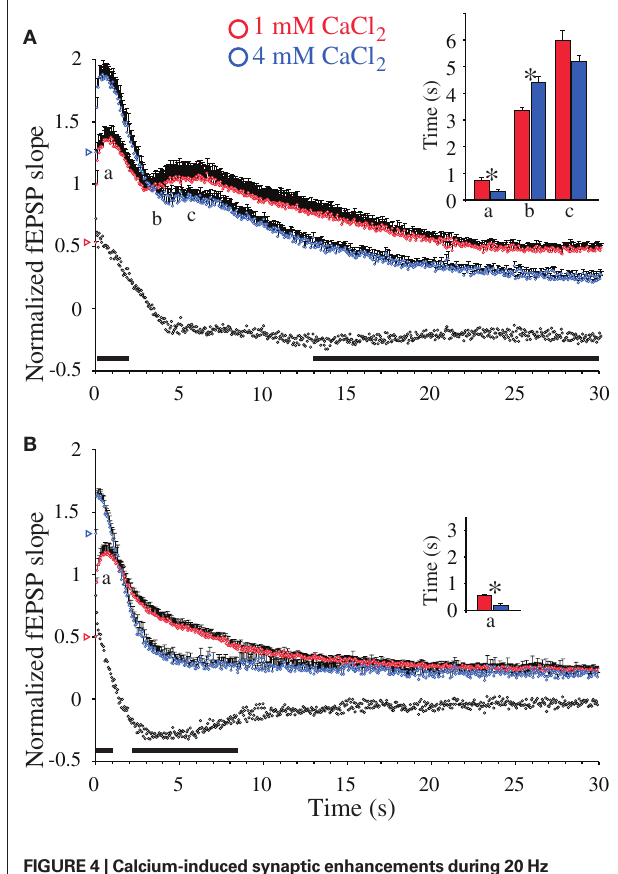
Figure 4 | Calcium-induced synaptic enhancements during 20 Hz stimulation in hippocampal excitatory CA3-to-CA1 synapses. (A) Normalized fEPSP slope measurements from CA3-to-CA1 synapses during 20 Hz stimulation in slices ( n = 12) from WT mice treated with 4 mM CaCl (blue 2 symbols) and in experiments with 1 mM CaCl ( n = 11, red symbols). Vertical 2 bars indicate S.E.M. Subtractions of the values at 1 mM CaCl from those 2 obtained at 4 mM CaCl are represented by the black, open symbols. The black 2 horizontal bar along the abscissa indicates p < 0.05 when comparing the two situations. Colored open triangles on the ordinate point to the starting value for the different conditions. a Indicates time point of the maximum magnitude of the initial frequency facilitation; b time to the transition point between the initial frequency facilitation and the DRE; c time needed to reach the peak of the DRE. The average measurements from individual experiments are shown Figure 5 | Synapsin-dependence of frequency facilitation and Dre as a in inset histogram with corresponding colored vertical bars. Vertical bars function of treatment with forskolin, PDBu, and 4 mM CaCl indicate S.E.M. * p < 0.05 when compared to the control situation. (B) As in of differences between measurements obtained in the presence of forskolin (A) but the slice experiments are from DKO mice treated with 4 mM CaCl (red symbols), PDBu (blue symbols), and 4 mM CaCl 2 ( n = 10, blue symbols) compared to experiments with 1 mM CaCl measurements obtained in control solutions in the synapsin DKO mice, from ( n = 12, 2 the corresponding differences seen in WT red symbols).